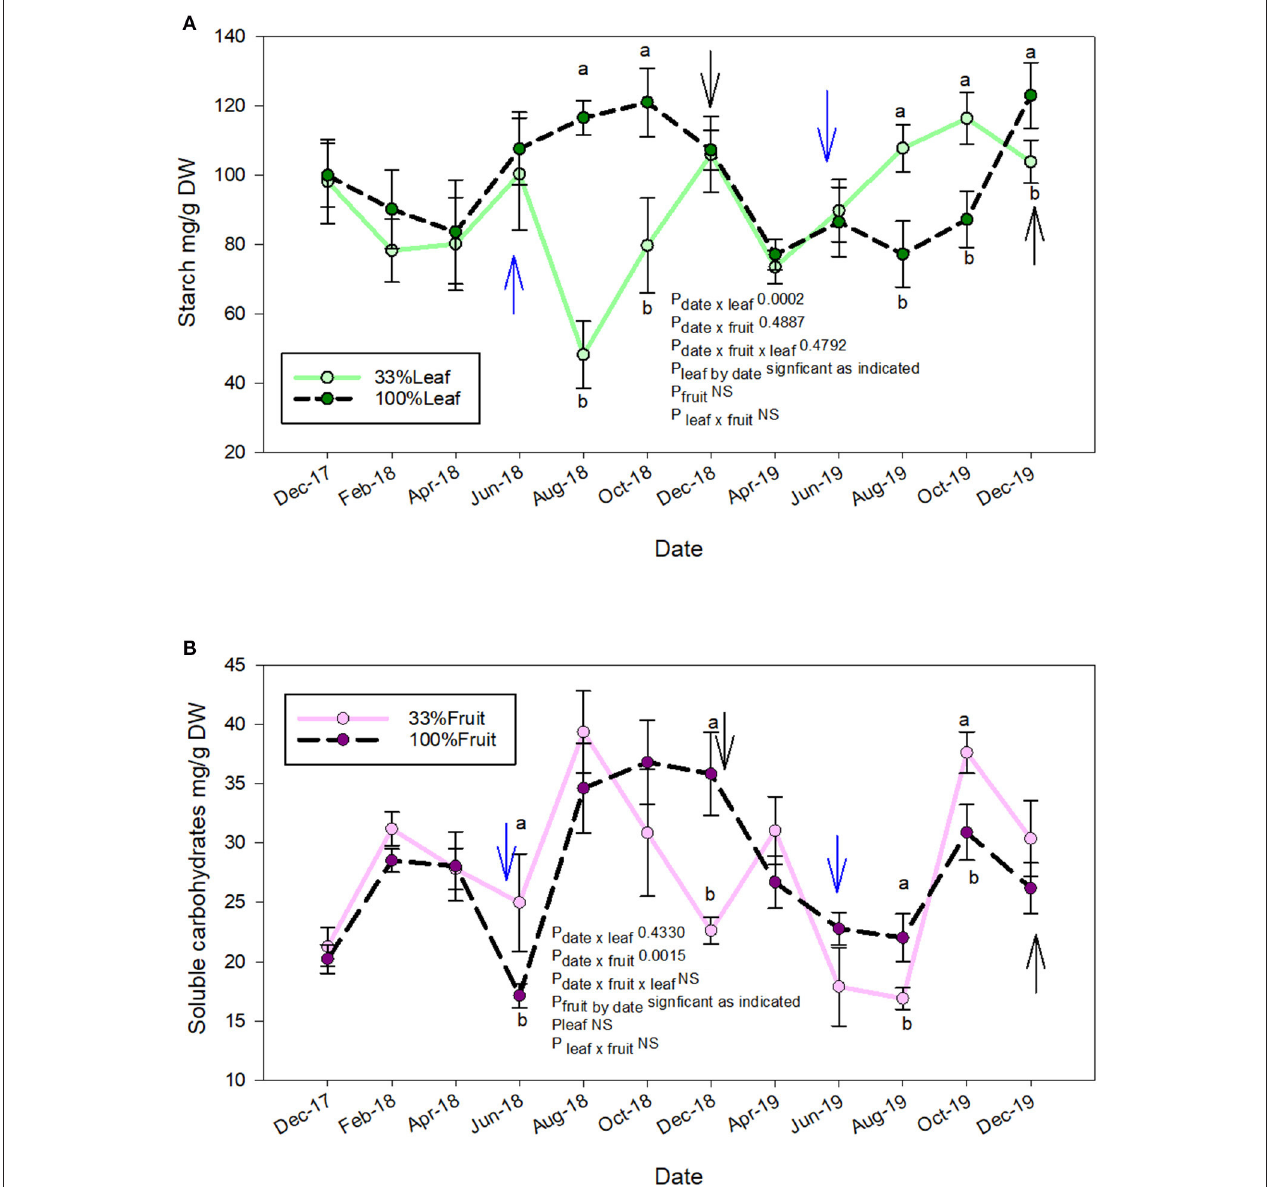
FIGURE 8 | Repeated measures analysis of measurement date, defoliation and fruit removal on root starch (A) and total soluble carbohydrates (B) , respectively on Cabernet Sauvignon grapevine. Blue arrow = treatments applied. Black arrow: pruning. Bars on each measurement date indicate standard error of the mean. Dates with different letter indicate significant difference at P < 0.05 on said time according to Tukey’s